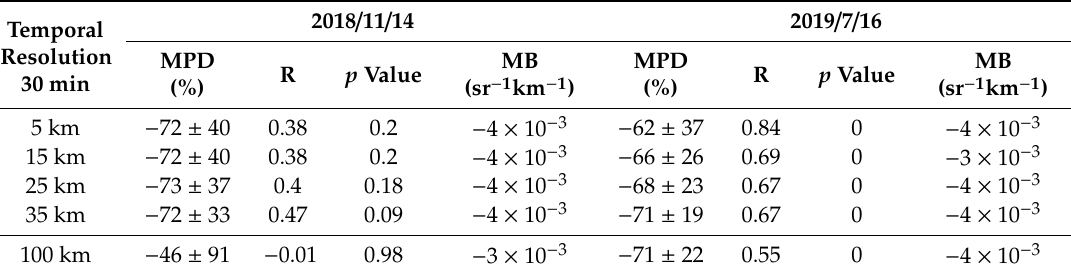
Table A4. Statistical results (Mean Bias (B), Correlation Coe ffi cient (R) and p value) derived from simultaneous measurements between CALIOP and Mace Head data for a cloud–free case (18 / 11 / 14) and for a case with a thin cloud (19 / 07 / 16) considering di ff erent along–track averages in CALIOP data (5 km, 15 km, 25 km, 35 km, and 100 km) and 30 min temporal resolution in Mace Head data.